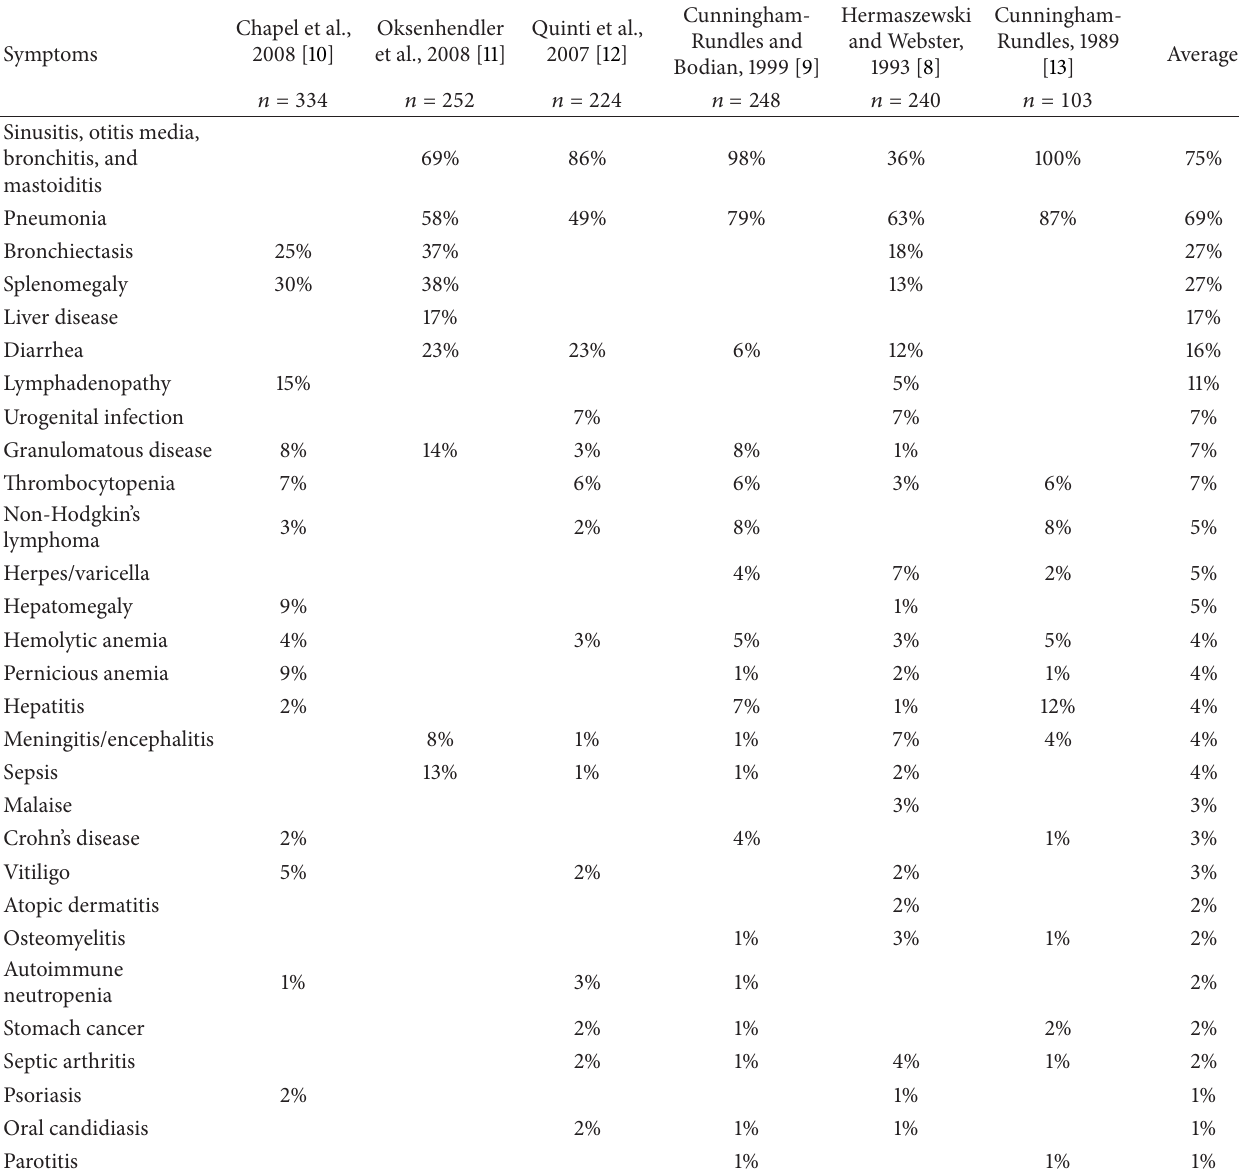
Table 2: Clinical manifestations of CVID